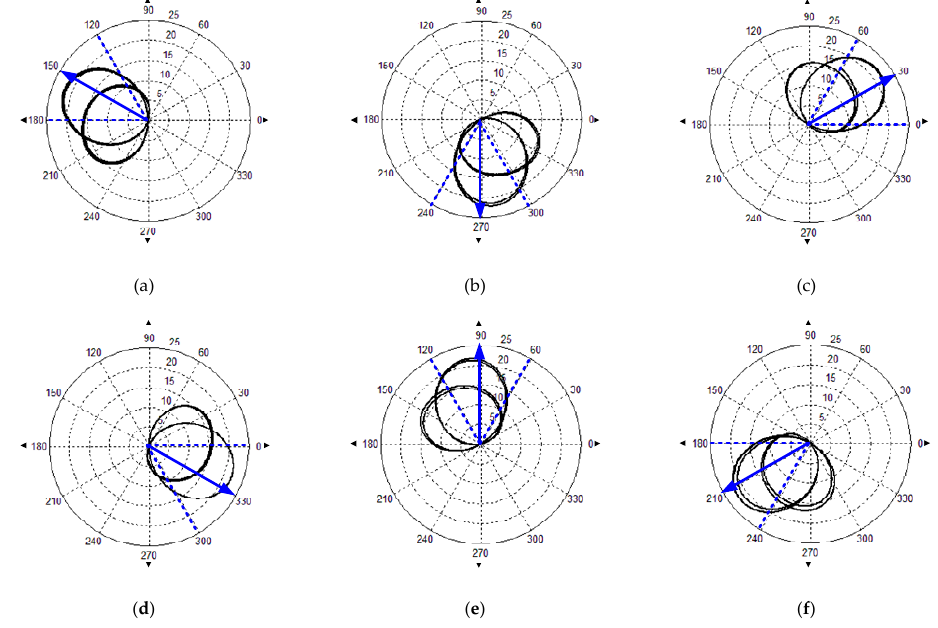
Figure 6. Vector trajectory and representative vector of DC-link voltage under open-switch fault condition. ( a ) S a 2 fault; ( b ) S b 2 fault; ( c ) S c 2 fault; ( d ) S a 3 fault; ( e ) S b 3 fault; ( f ) S c 3 fault.